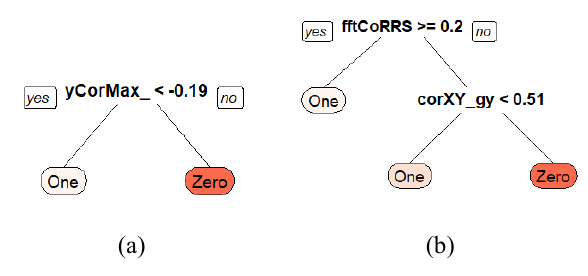
Figure 5. The trained decision trees that achieved the best performance on classifying good and poor coordination during (a) chest rotation and (b) pelvis rotation.